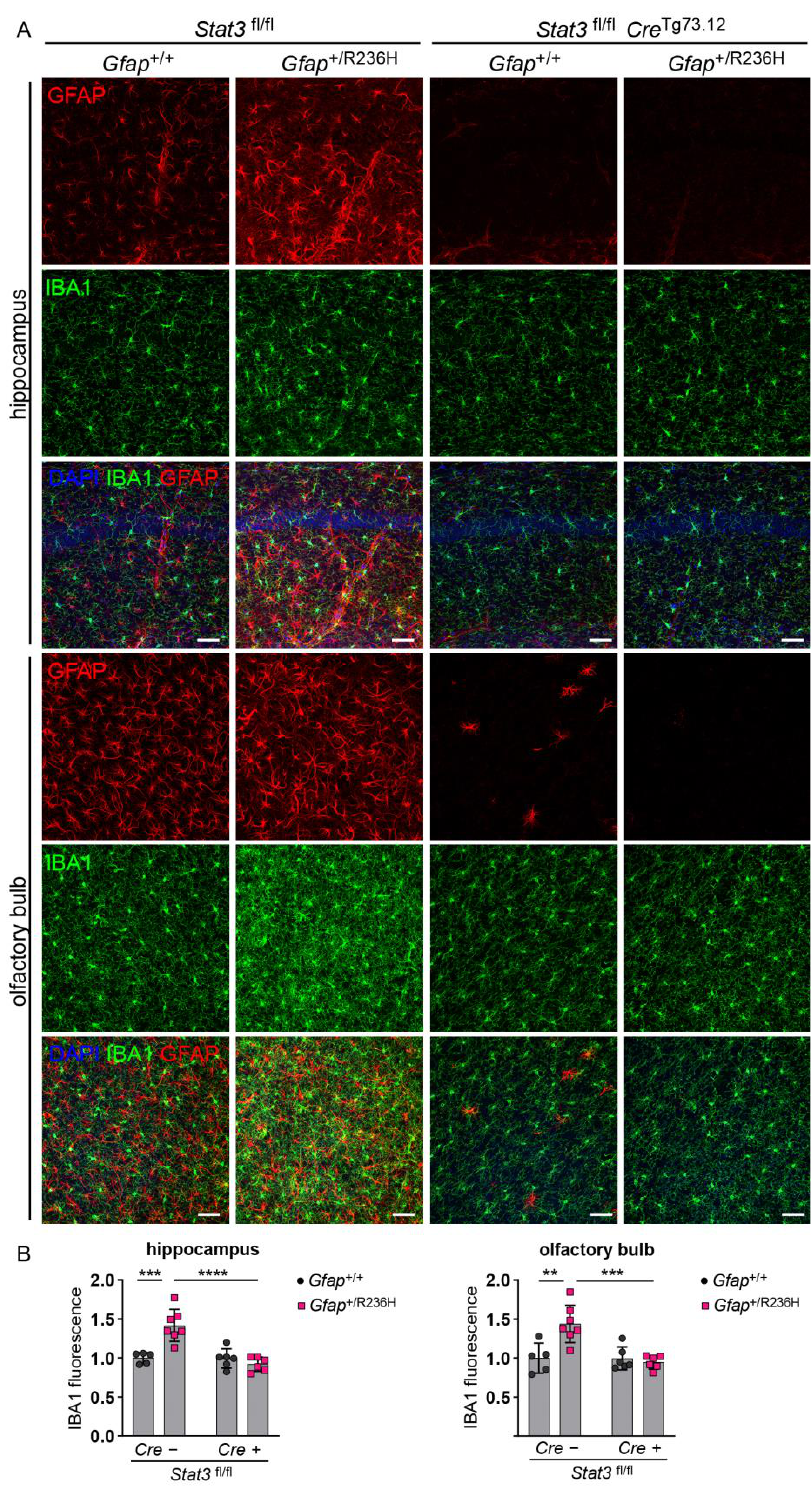
Figure 6. Iba1 expression in microglia from AxD model mice with conditional knockout of Stat3 in Gfap expressing cells. ( A , B ) Immunofluorescence labeling ( A ) and quantification ( B ) of Iba1 in hippocampus and olfactory bulb from Gfap +/R236H mice and Gfap +/+ littermate controls (6 months of age) collected from the same Stat3 fl/lf , Cre Tg73.12 genetic cross as shown in Figure 4A. GFAP is also labeled for comparison. Values in ( B ) represent fold change relative to the average for Gfap +/+ ; Stat3 fl/fl ; Cre (-) mice. C57BL/6J males and females, two-way ANOVA with Sidak’s post-tests, ** p < 0.01, *** p < 0.001, **** p < 0.0001, ns = not significant. Scale bars = 50 µ